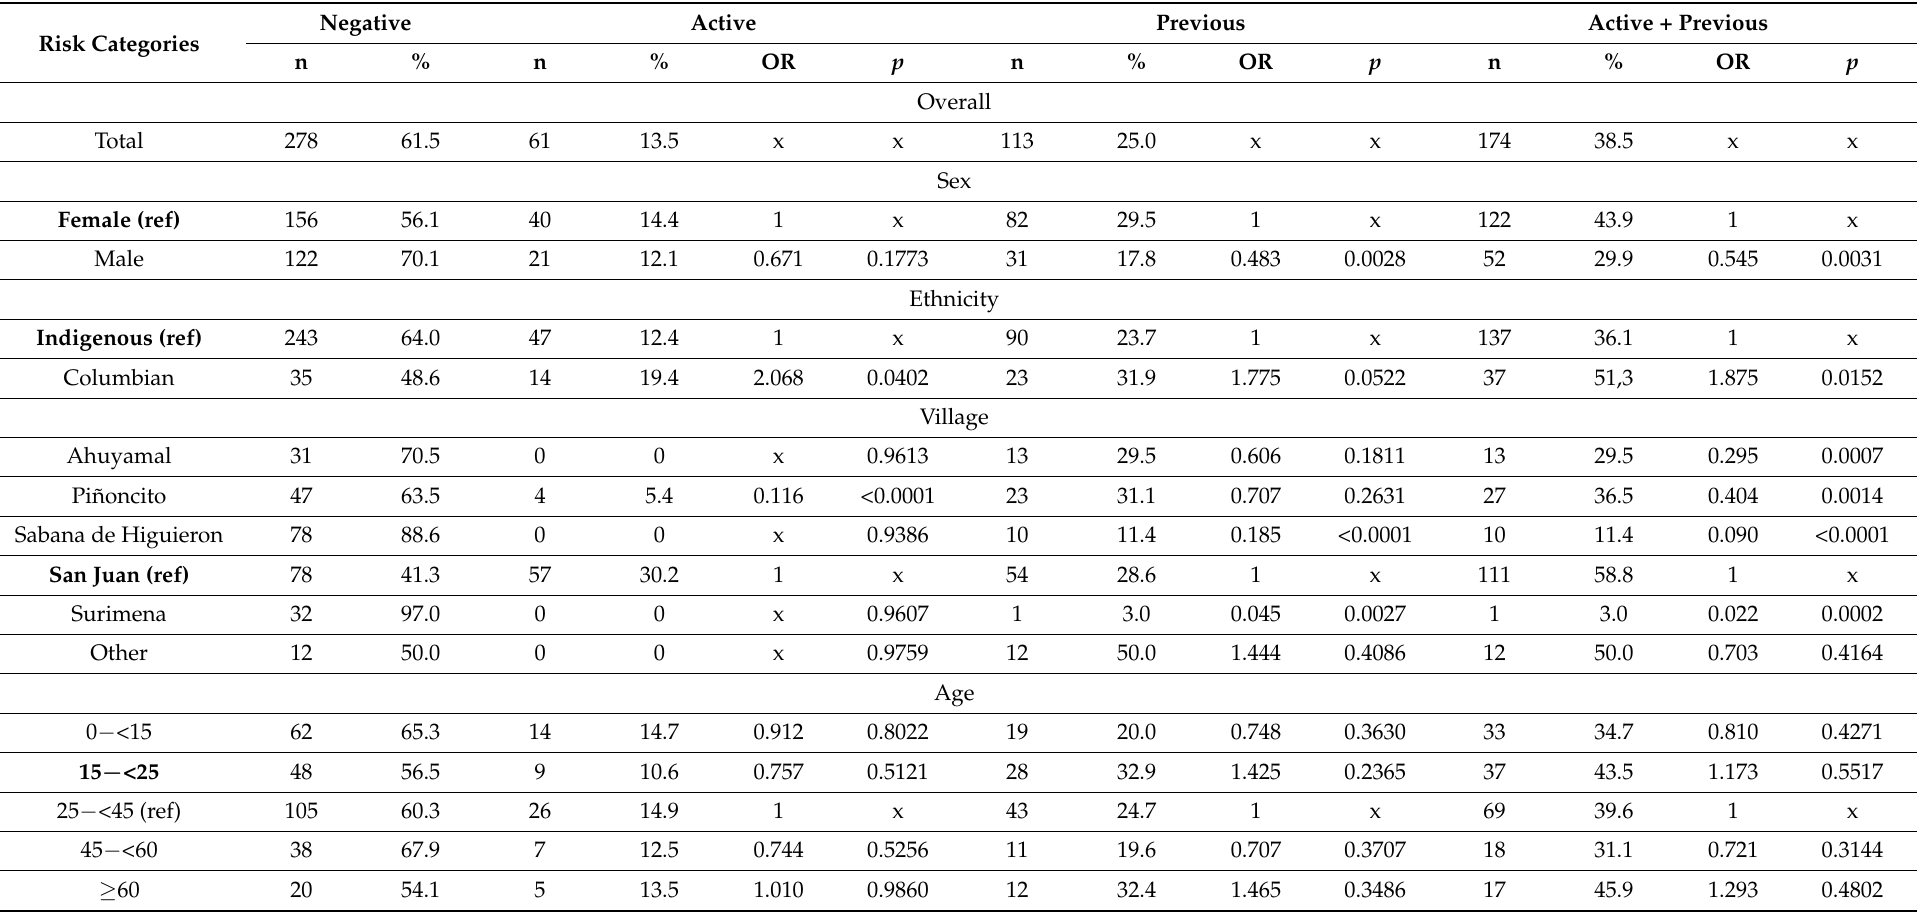
Table 2. SARS-CoV-2 status by risk categories—results of univariable logistic regression analyses (all statistical tests within the logistic regression were compared with SARS-CoV-2 negative tests; for factors comparing groups the reference category is marked in